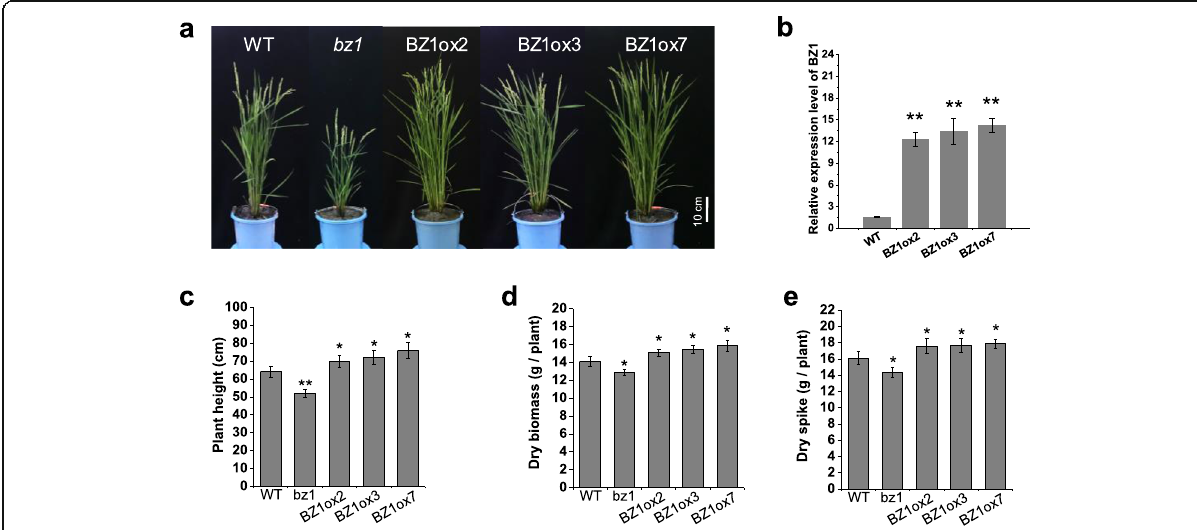
Fig. 6 Agricultural traits of bz1 plants and transgenic rice lines overexpressing BZ1. a Phenotypic differences of wild-type (WT), bz1 , and transgenic line BZ1ox2, BZ1ox3, and BZ1ox7 at the grain-filling stage grown in paddy fields. b qRT-PCR analysis of the expression of BZ1 in WT and BZ1 overexpressing lines. c-e Plant height ( c ), dry biomass ( d ) and dry spike ( e ) were increased in transgenic plants overexpressing BZ1 . * and ** indicates significant differences between WT and bz1 , BZ1 overexpressing lines by t -test at P < 0.05 and 0.01,